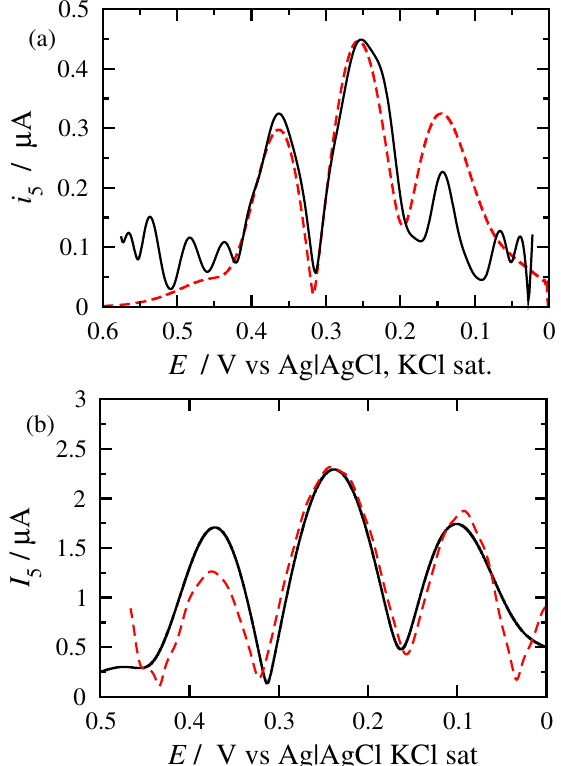
Figure 7. Experimental (black) versus computational (red dashed line) of the 5th harmonic of Mt LPMO9H immobilised on a Co-f-MWCNTs modified GC electrode at 25 ◦ C. Experimental condi- tions: acetate buffer 500 mM, pH 6, f = 1 Hz and ( a ) A 0 = 0.2 and (b) 0.25 V. Computational parameters: a=0.57, f = 1 Hz, (a) A 0 = 0.2 V, Γ 0 S = 3 × 10 − 13 mol and ( b ) A 0 = 0.25 V, Γ 0 S = 1.2 × 10 − 12